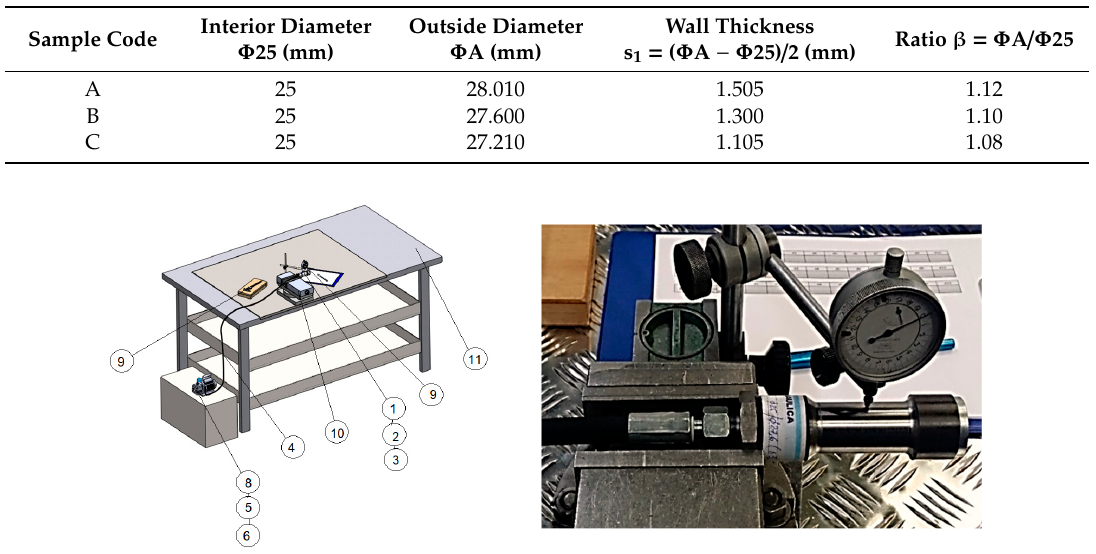
Figure 3. Variation of cyclic loading: zero-tension cycle. Table 2. Geometrical characteristics of samples tested to cyclic internal pressure.